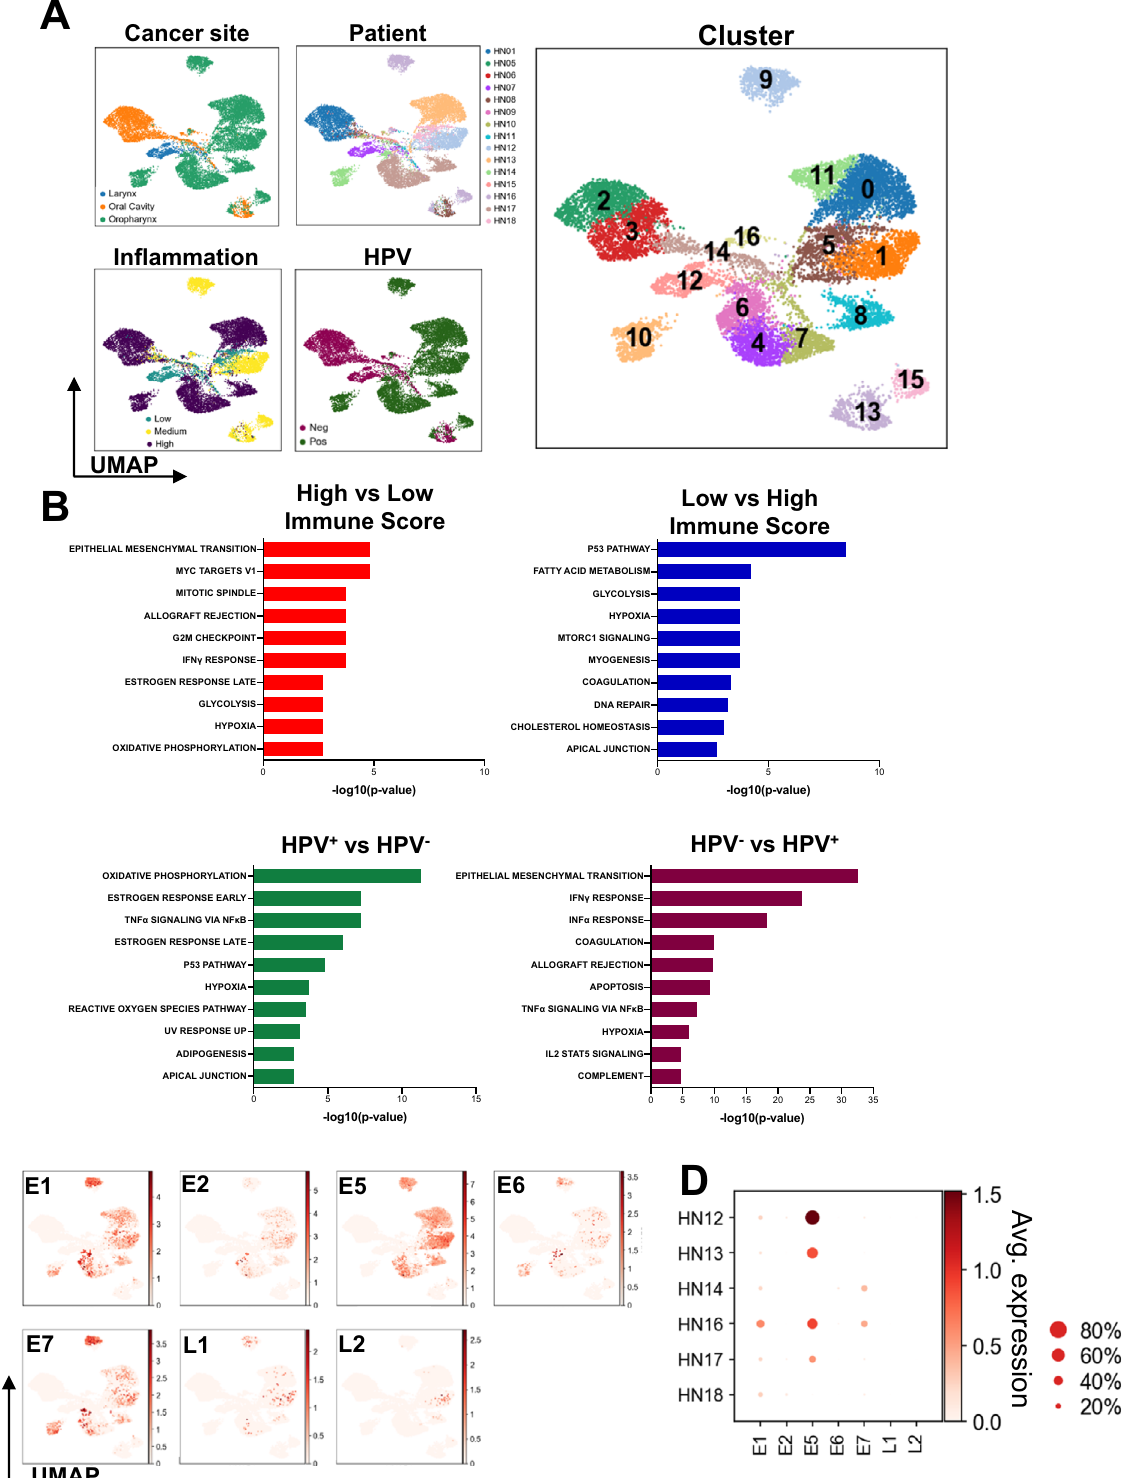
Fig. 3 Squamous epithelial cancer cells and HPV gene expression. A Sub-clustering of 14,920 epithelial cells ( n = 15 patients; cluster 0 – 16) and visualization of relevant characteristics: patient contribution (HN01, HN05 – HN18), viral-status (HPV + vs. HPV – ), cancer site (larynx, oral cavity, oropharynx) and in fl ammation score (low, medium, high). B Hallmark gene sets enriched (using the Computer Overlaps tool from MSigDB) in epithelial cells derived from tumors with low vs. high in fl ammation score, as well as HPV + vs. HPV – lesions (and vice versa, all p < 0.0001). p -values for enrichment were extrapolated from hypergeometric distribution. C UMAP visualization of transcripts of HPV16 genes ( E1 , E2 , E5 , E6 , E7 , L1 , and L2 ) in epithelial cells. D HPV + patient-speci fi c intensity and prevalence of HPV16 gene expression. Color bar indicates normalized gene